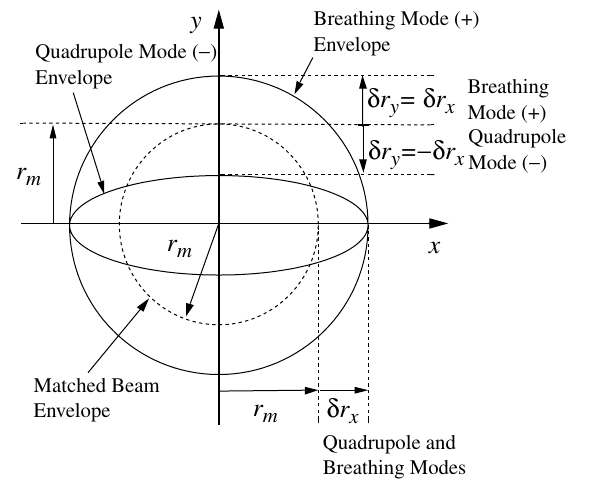
(cid:1) r (cid:1) r in x y m (cid:1) (cid:2) %r ) mode perturba- x y